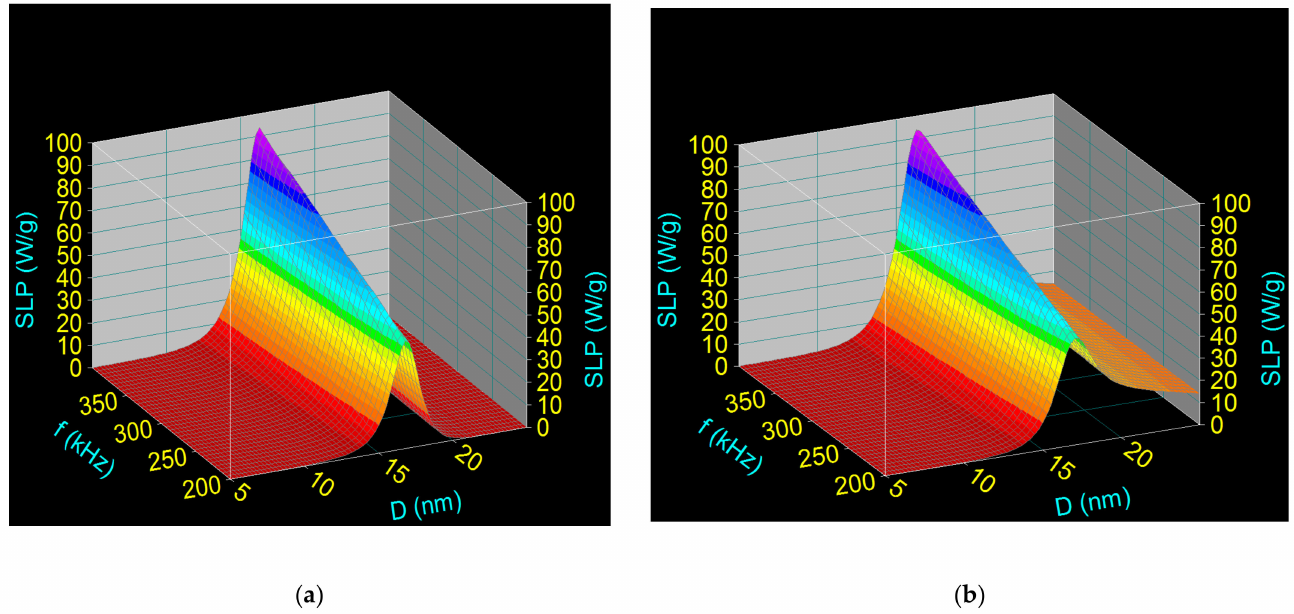
Figure 3. Specific loss power as a function of the nanoparticle diameter and frequency of the magnetic field and H = 16 kA/m, in the cases: ( a ) Fe 3 O 4 -PAA–(HP- γ -CDs) fixed nanoparticles, and ( b ) Fe 3 O 4 - PAA–(HP- γ -CDs) mobile nanoparticles.